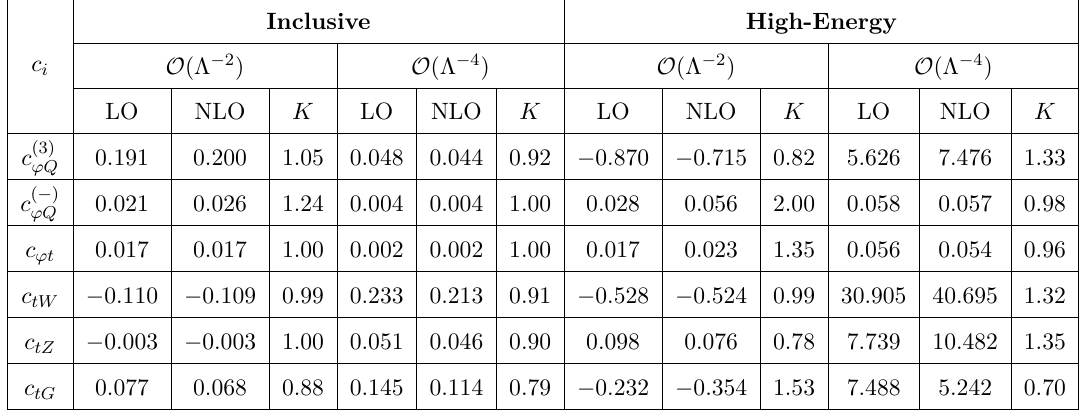
Table 4 . Relative SMEFT operator contributions (DR2 predictions) to inclusive and high-energy tWZ production. The cross sections are normalised by the corresponding LO(NLO) SM predictions in the inclusive and high-energy regions shown in table 2. Individual operator impacts are split into contributions from interference with the SM, O (Λ − 2 ) , and pure SMEFT amplitude squared, O (Λ − 4 ) . The NLO numbers are represented in figure 8, and K -factors are defined as the ratio between NLO and LO